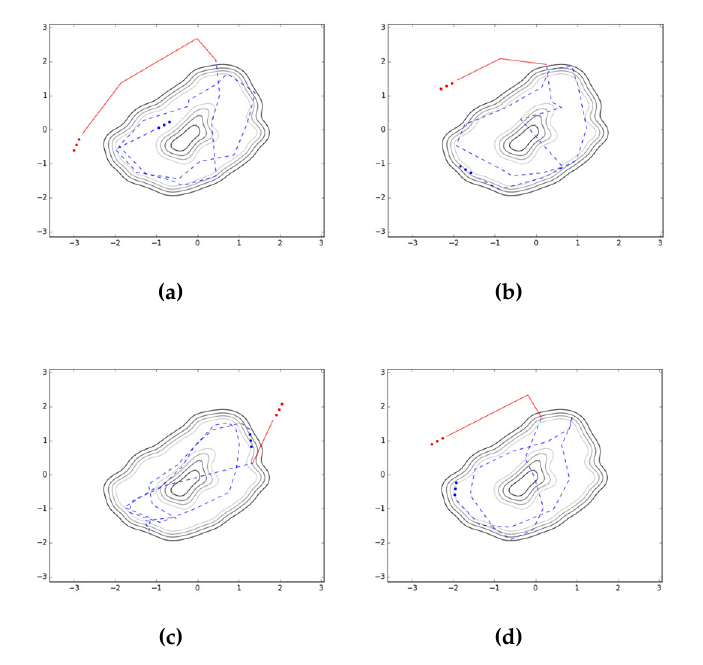
Figure 8. Detecting falls by GP (solid lines for trajectory after fall, and dashed lines for trajectory before fall): left, right, forward, and backward falls. Considered fall trajectories: ( a ) left, ( b ) right, ( c ) forward, ( d )